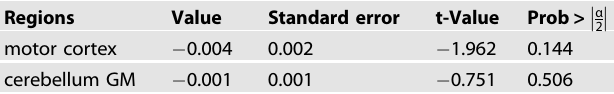
Table 1. Slope values and SE in control regions.